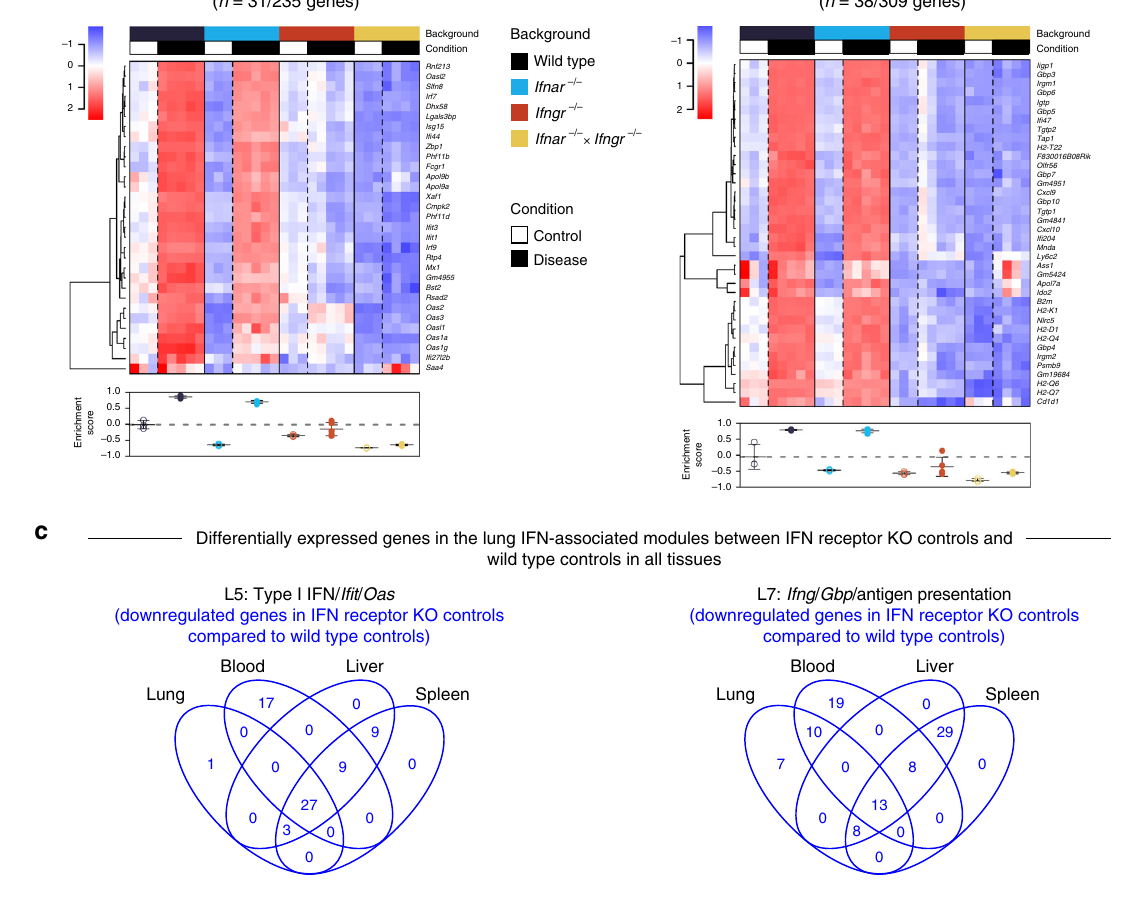
Fig. 11; Supplementary Data 15). Similar fi ndings were observed in the blood, liver and spleen of uninfected Ifnar − / − , Ifngr − / − and double Ifnar − / − × Ifngr − / − versus Wild type uninfected mice (Supplementary Figs. 12 – 17; Supplementary Datas 16 – 18). The absence of type I IFN signaling in the Ifnar − / − mice showed a robust but not absolute decrease in the induction of the